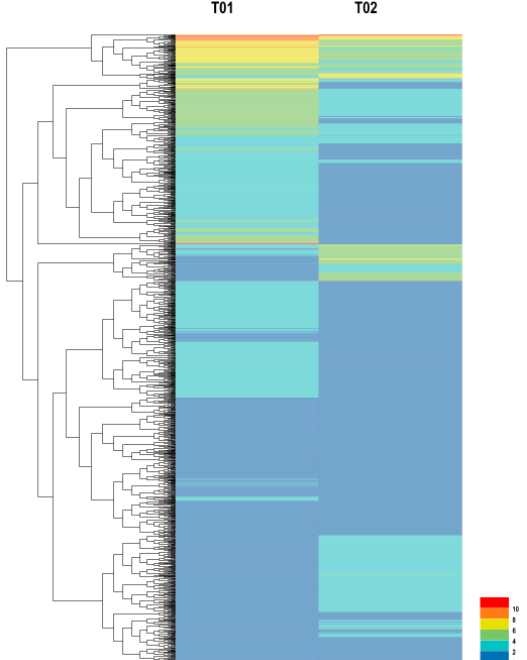
Figure 2. Cluster analysis of DEGs in WT and MT plants, based on expression profiles measured by RNA-seq; the color scale in the heat map corresponds to log2 (Fragments Per Kilobase Million (FPKM)) values of genes in the different samples.